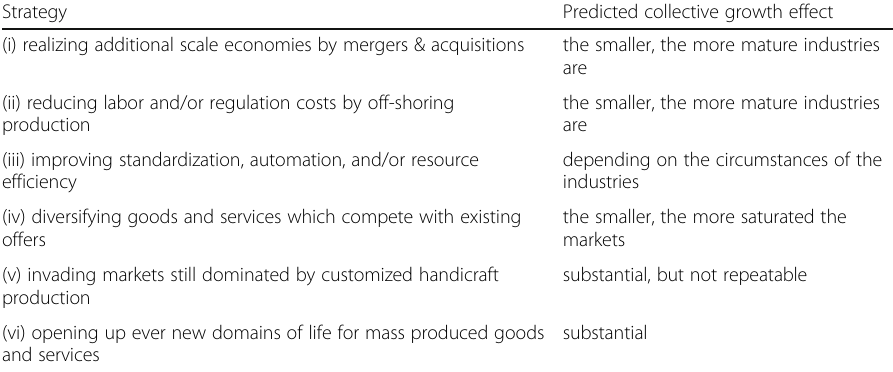
Table 2 Individual Adaptation Strategies to Over-accumulation Crisis and Their Predicted Collective Effect on Economic